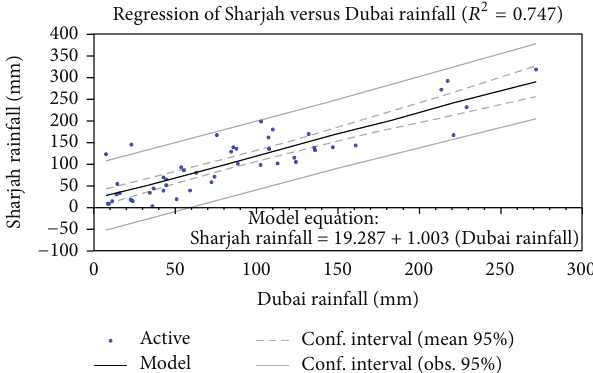
Figure 1: Linear regression of Sharjah versus Dubai and its model equation.